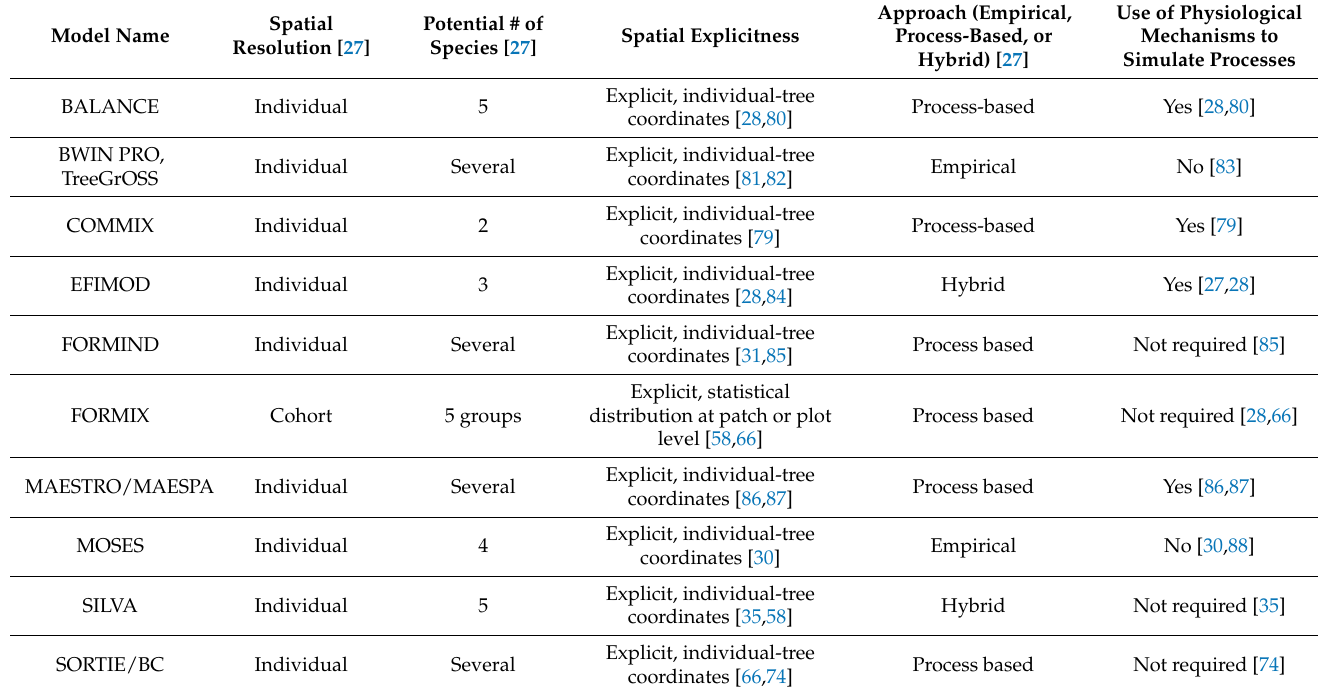
Table 1. Model characteristics of the 10 reviewed distance-dependent, multi-species models that simu- late tree coordinates of more than one tree species at an individual-tree or patch level. Characteristics include spatial resolution, species capacity, (horizontal) spatial explicitness of distance-dependence, modeling approach, and whether the model represents physiological processes